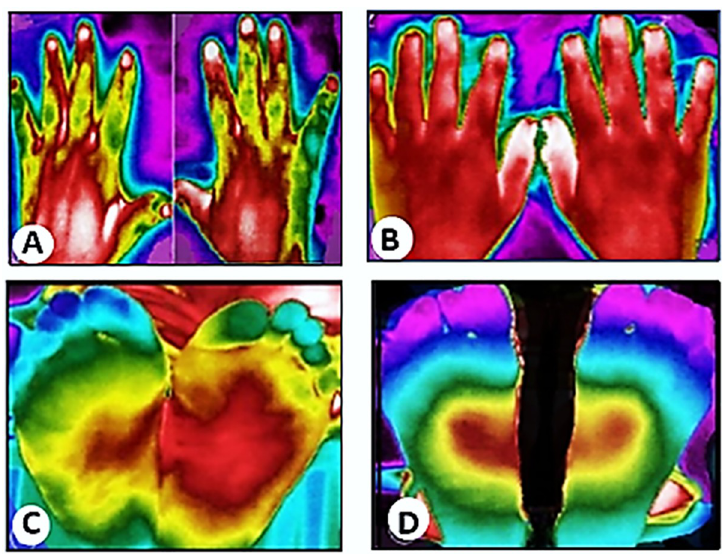
Fig 4. Infrared thermal imaging. (A) Thermal image of the dorsal region of the hands of patient with leprosy; (B) Thermal image of dorsal region of the hands of a healthy individual; (C) Thermal image of feet of a patient with leprosy; (D) Thermal image of the plantar region of feet of a healthy